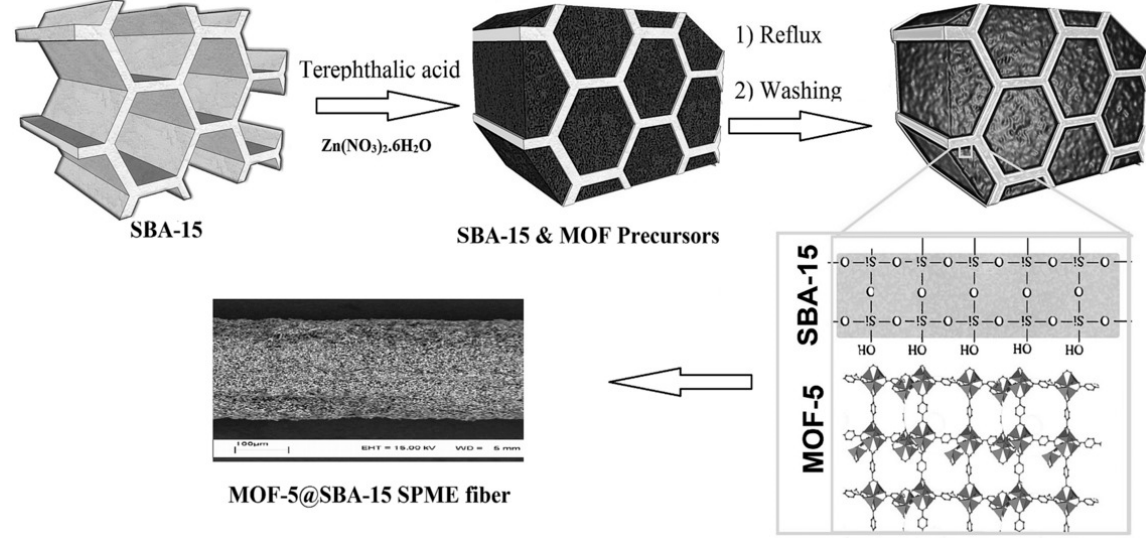
Figure 3. Synthesis of MOF-5@SBA-15 hybrid nanomaterial via an impregnation approach to grow MOFs only in the pores of porous silica materials. Reproduced from [83], with permission from Wiley-VCH, 2018.